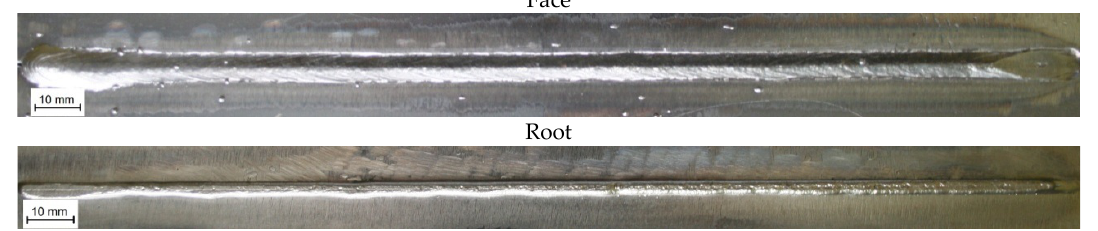
Figure 7. The face and the root of the hybrid welded joint (laser beam-MAG) in steel S700MC.